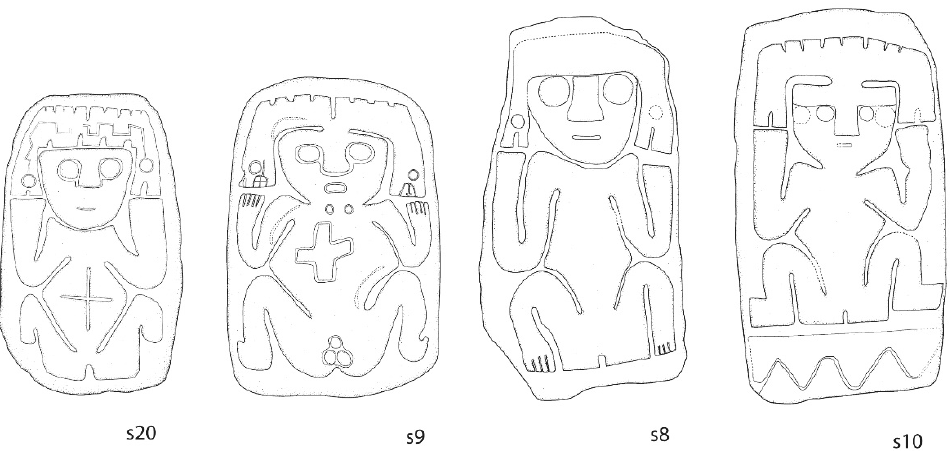
Figure 8. Drawing showing four (of nineteen) vertical slab sculptures documented at Chinchawas. The variability in frontal figure depiction and lack of standardization in size and quality indicate slow periodic production and accumulation of ancestor figures for the community’s local ‘descent-scape.’ Sculpture s10 is 127 cm tall. Drawings by